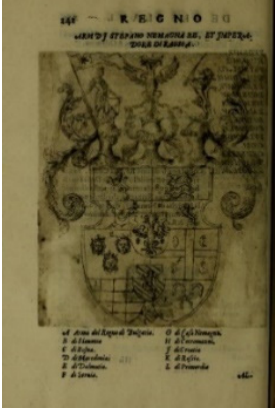
Figure 19. The dominion CoA of Nemanich from Il Regno degli Slavi.